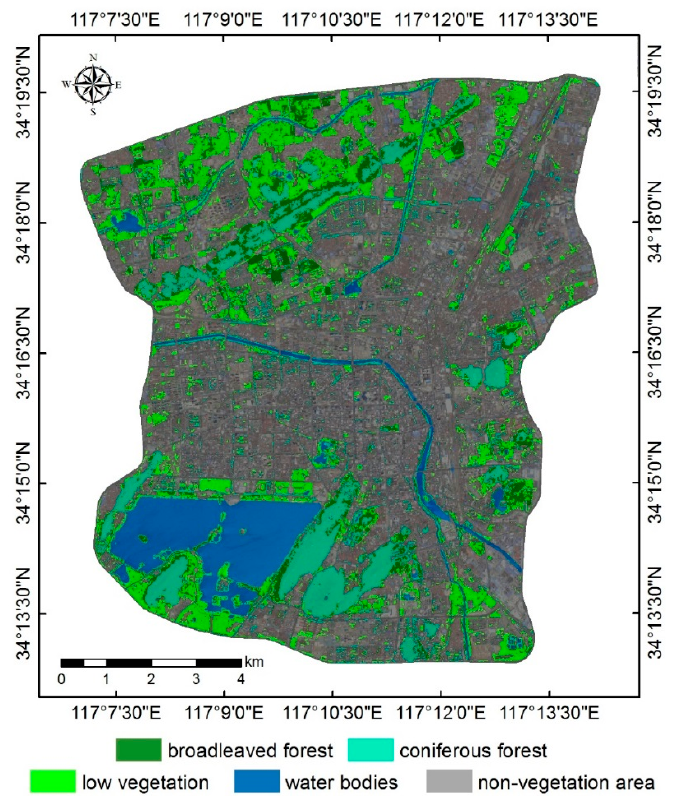
Figure 3. Urban vegetation classification by support vector machine.